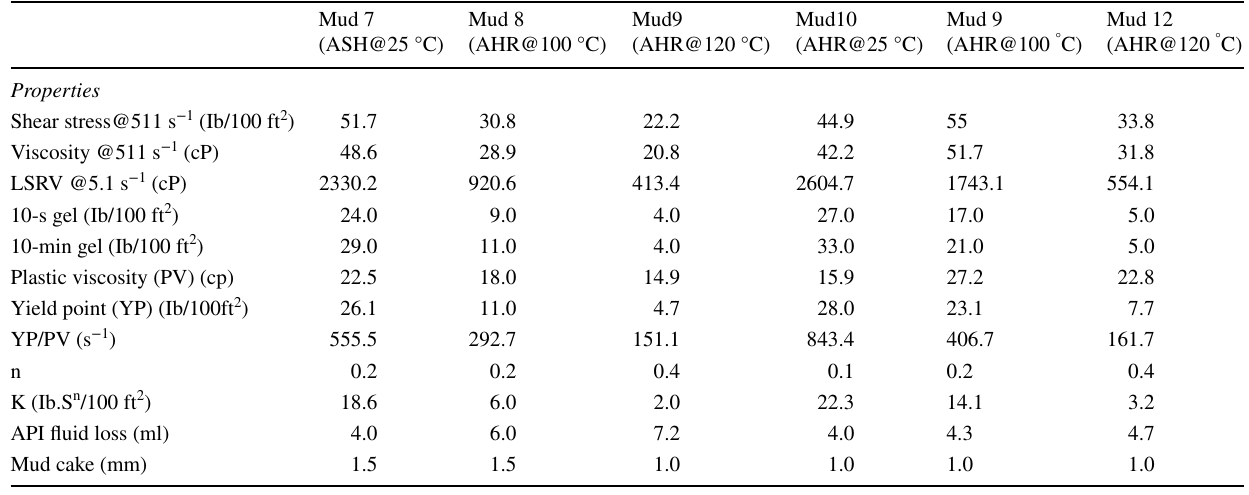
Table 4 Properties of the drilling muds containing salt